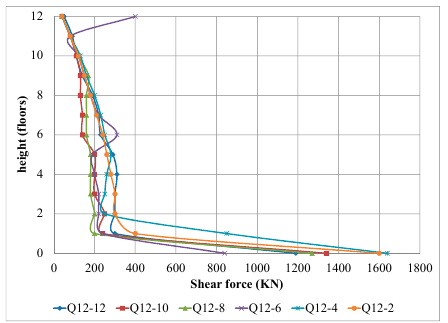
Figure 19. Shear force over the height of the tall building in the two adjacent buildings with unequal foundation levels and SSI.